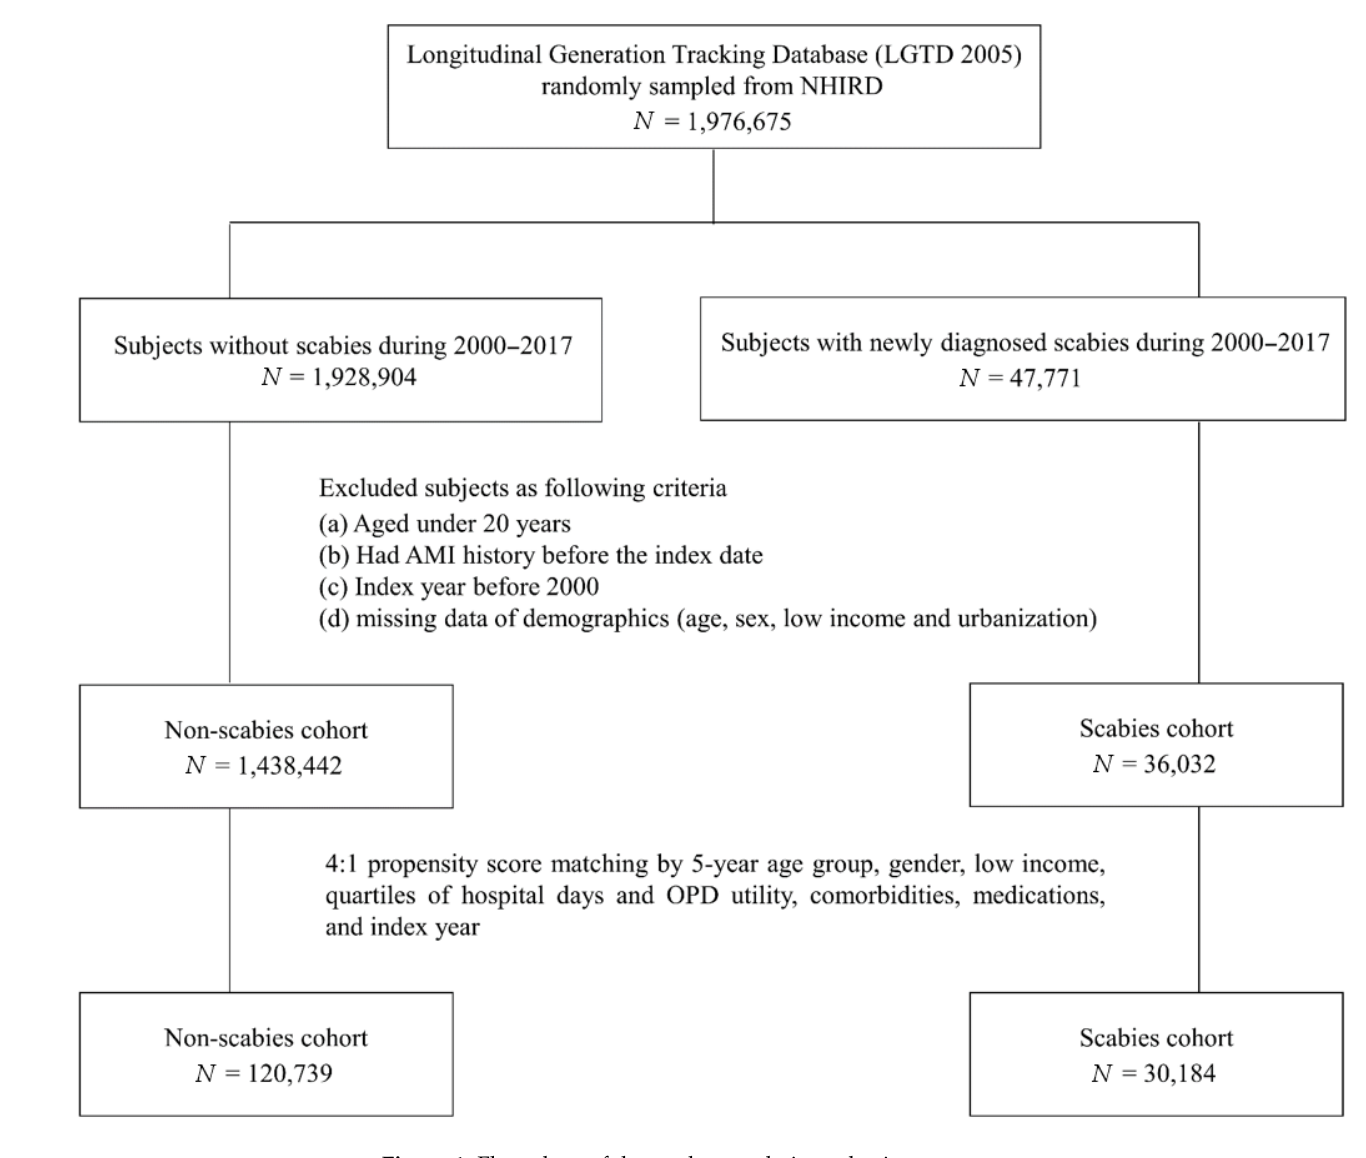
Figure 1. Flow chart of the study population selection.